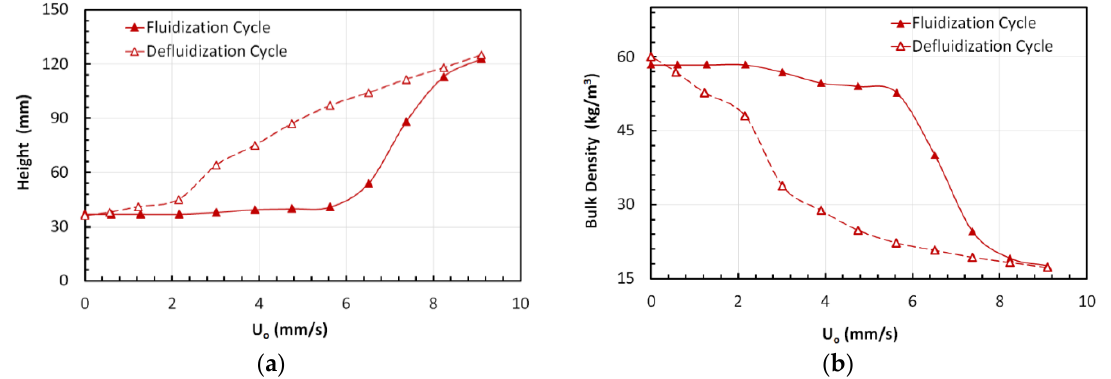
Figure 10. Effect of velocity on the bed expansion ( a ) Bed height; ( b ) Bulk density. Figure 10. E ff ect of velocity on the bed expansion ( a ) Bed height; ( b ) Bulk